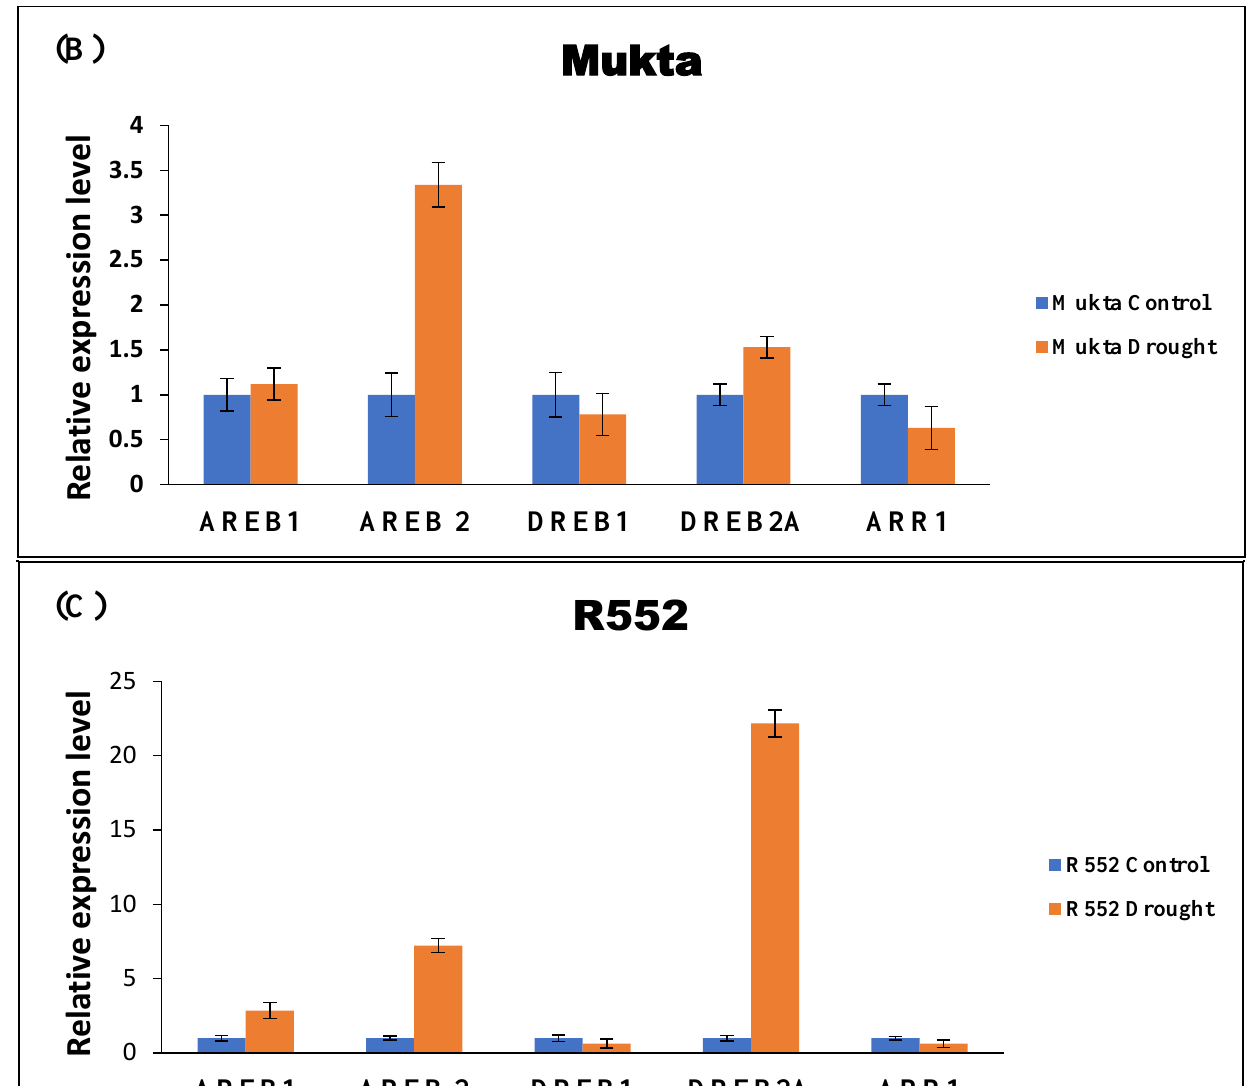
Figure 3. Expression analysis of selected five DRGs with respect to EF1a in three cultivars of flax. Error bars indicate ± SE of three biological